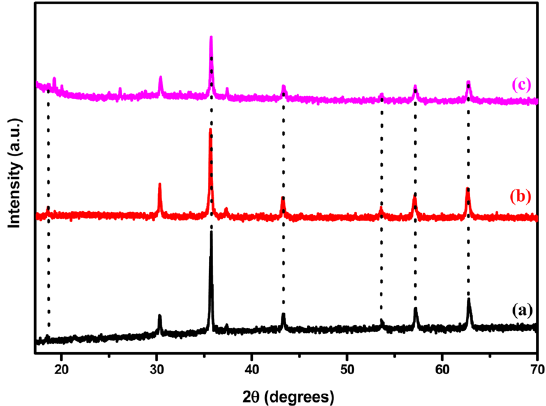
Figure 3. XRD patterns of ( a ) Fe 3 O 4 , ( b ) silica coated and ( c ) acid functionalized